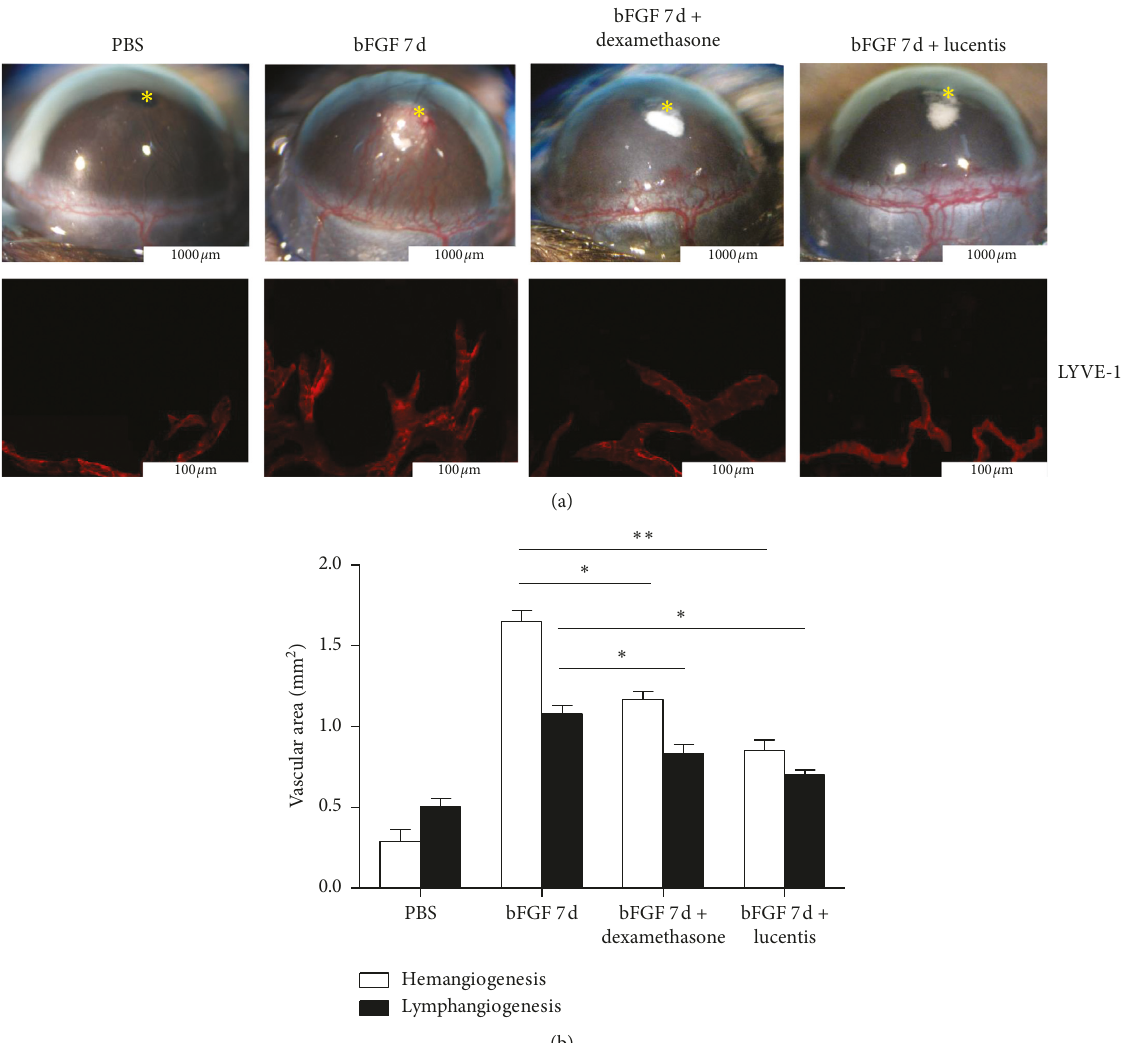
Figure 3: Expression of lymphangiogenesis- and hemangiogenesis-associated factors. (a) Corneal hemangiogenesis and lymphangiogenesis (LYVE-1, red) were reduced by dexamethasone and ranibizumab, but ranibizumab had a stronger inhibitory effect (bar, 1000 μ m; 100 μ m) ∗ Sites of pellet implantation. (b) Quantitative analysis of lymphangiogenesis and hemangiogenesis in the treatment group ( n � 4–6). ∗ P < 0 . 05; ∗∗ P < 0 .